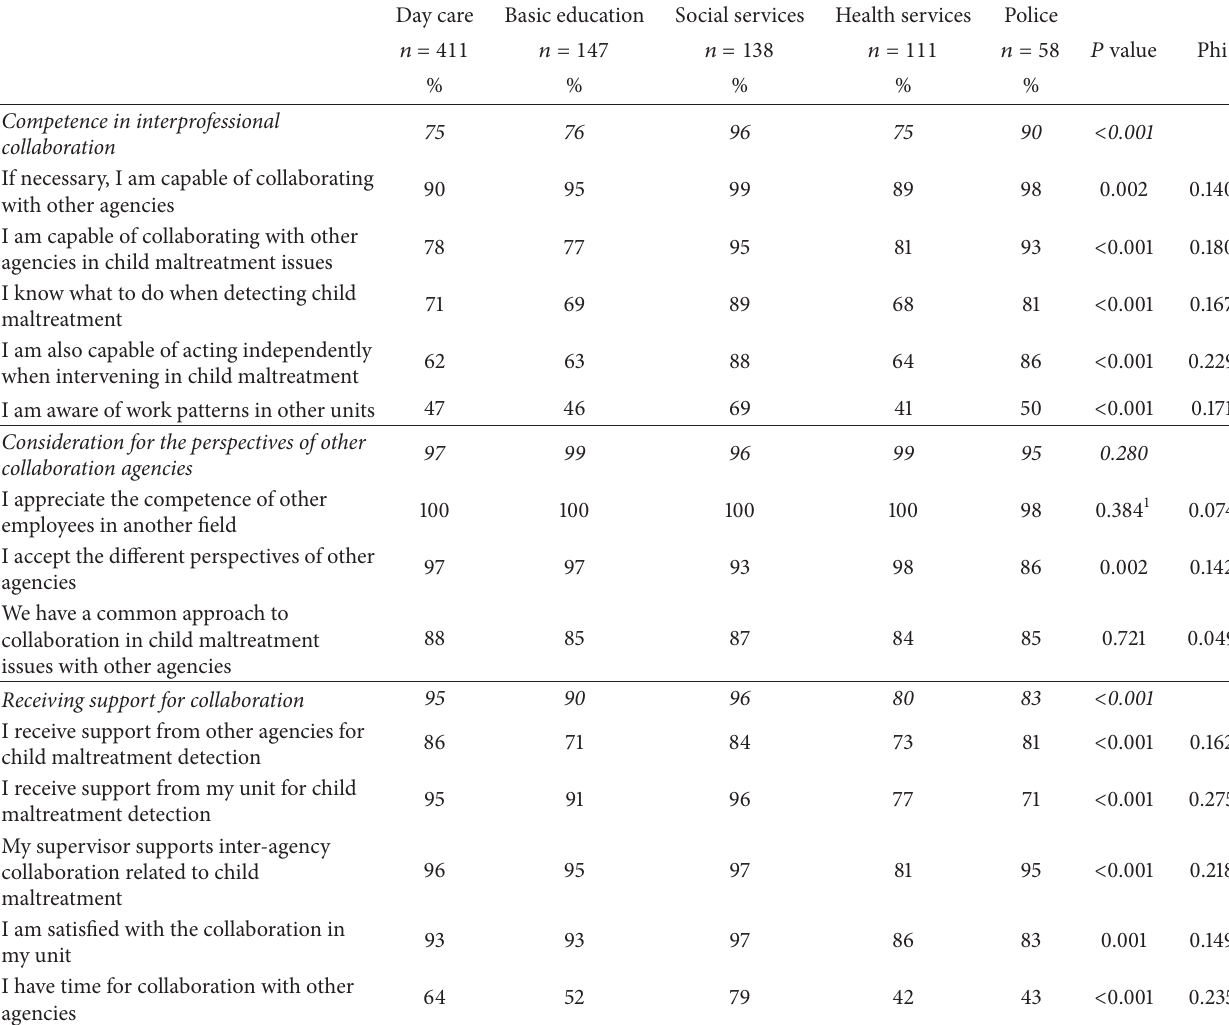
Table 3: Employee perceptions of competence in interprofessional collaboration. Percentages of those agreeing with the item. Statistical differences between the fields were tested using the Pearson Chi-square test or Fisher’s Exact Test ( 𝑛 = 865